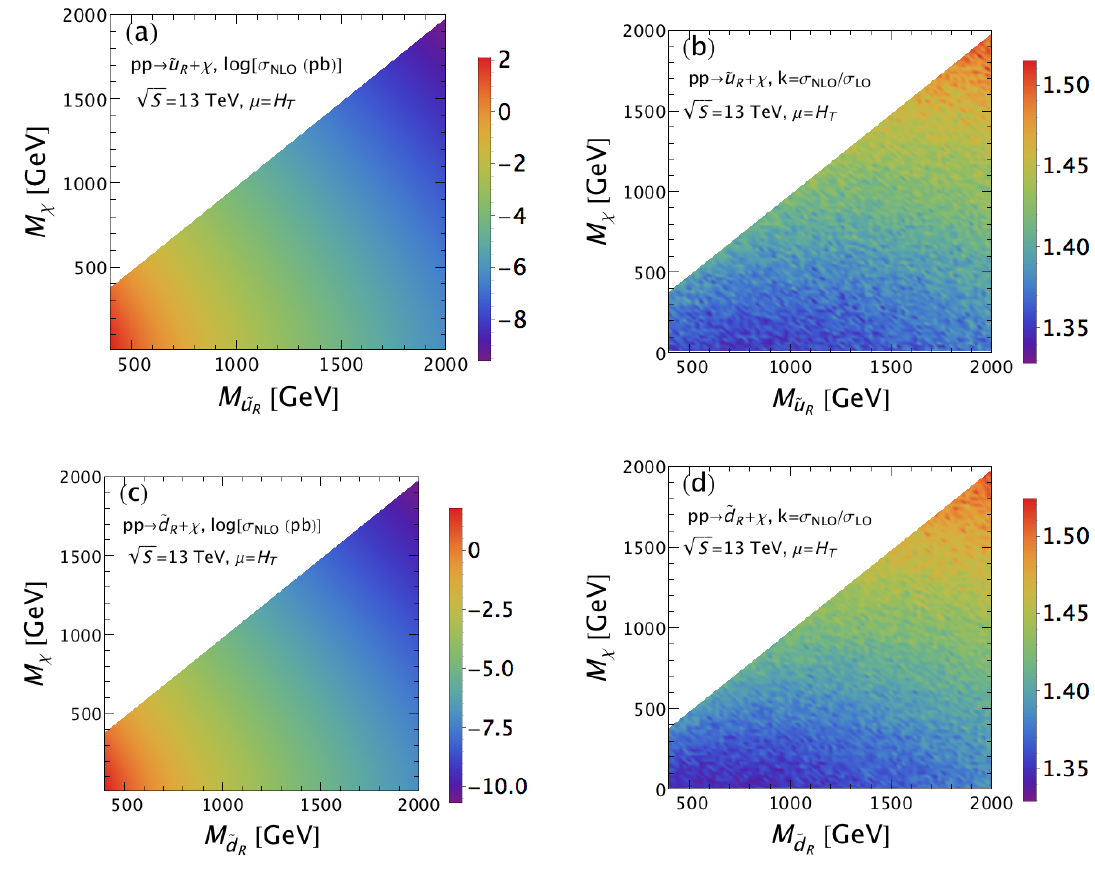
Figure 10 . The production cross section and k -factor for associated mediator plus dark matter production in the u R model (upper) and d R model (lower) at the 13 TeV